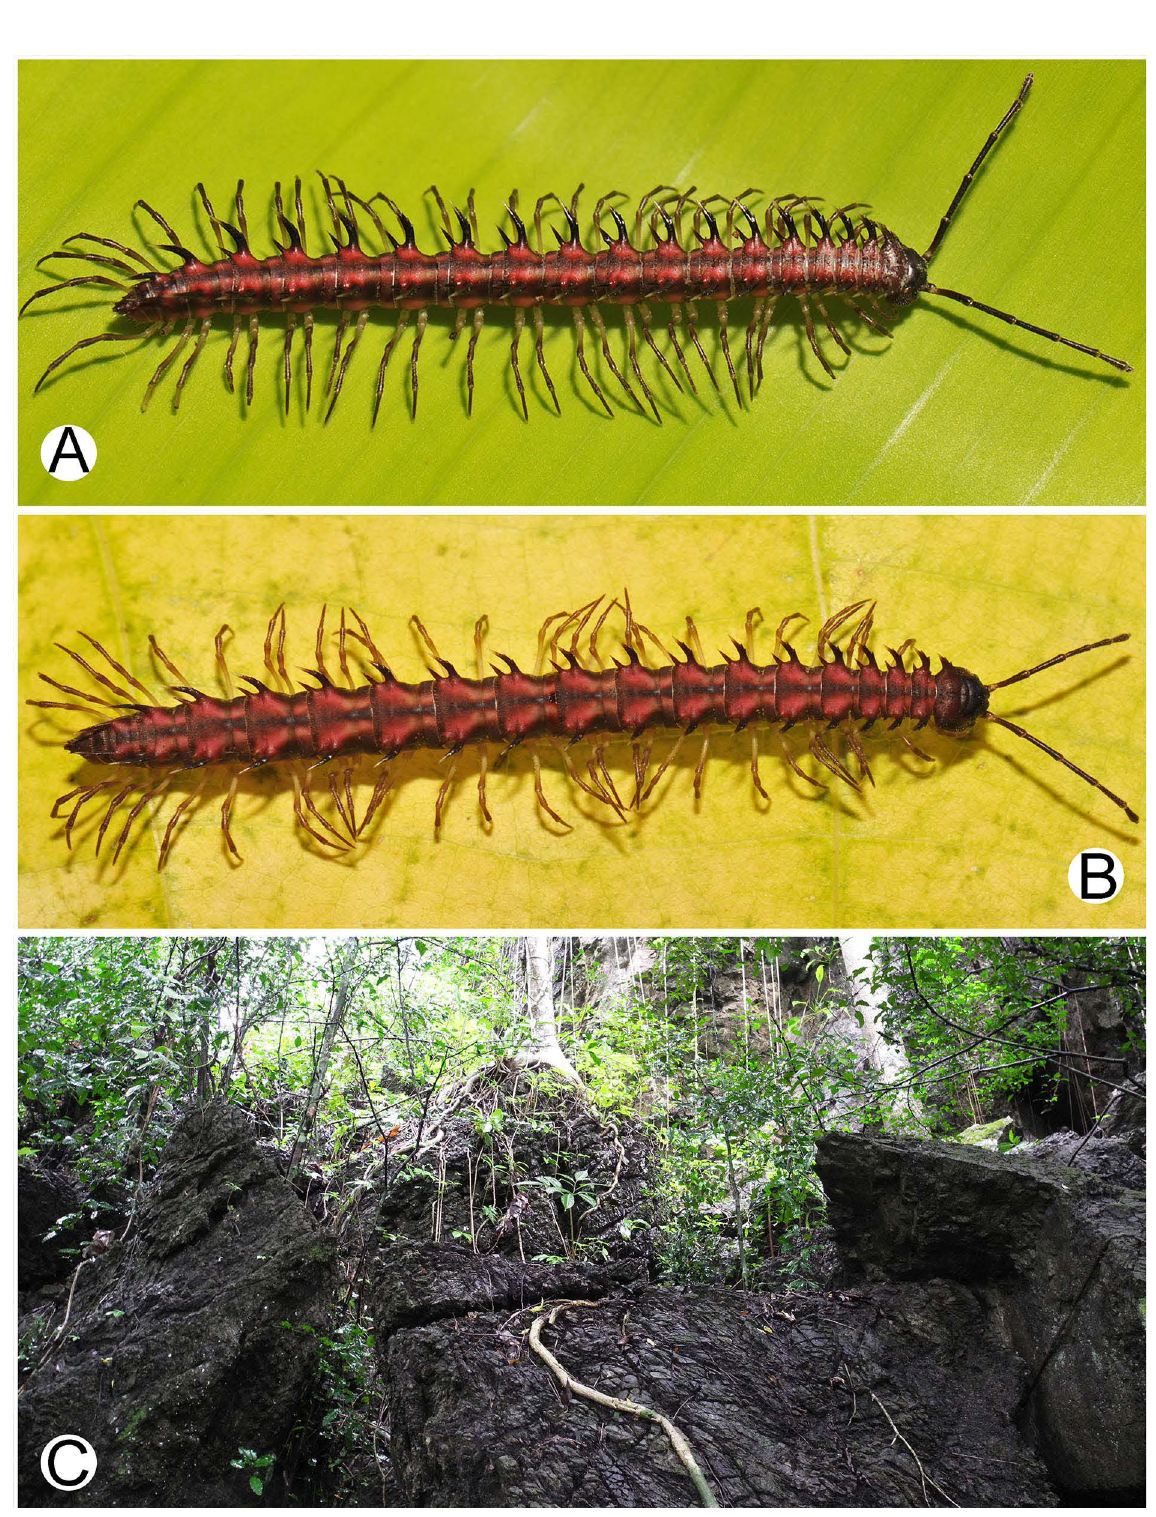
Fig. 14. A – B . Photographs of live Gigaxytes parvoterga Srisonchai, Enghoff & Panha gen. et sp. nov . , specimens from Tham Khao Ting A . ♂ paratype. B . ♀ paratype. C .